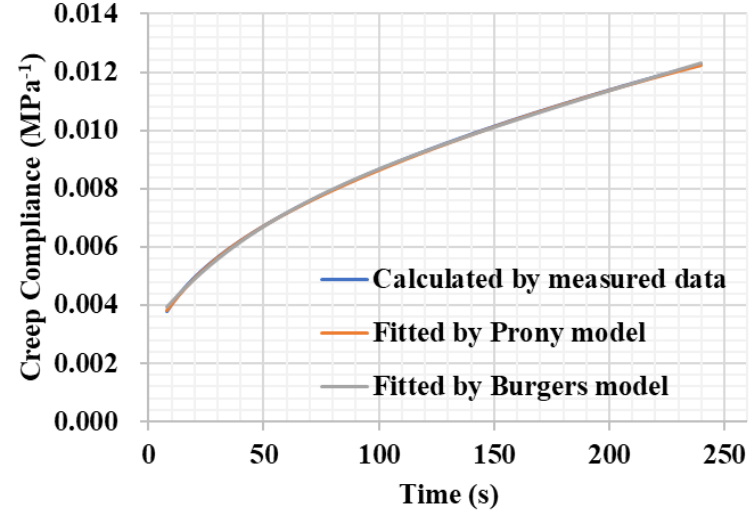
Figure 6. Creep compliance curves determined using different methods in a BBR test. In the Burgers model, E 1 and E 2 are the instantaneous elastic modulus of the Maxwell model and the delayed elastic modulus of the Kelvin model, respectively, while both η 1 and η 2 are viscous coefficients. These viscoelastic parameters can further calculate the indexes of relaxation time λ and the delay time τ , which are determined using Equations (6) and (7). Relaxation time λ shows the ability of asphalt binder to release internal stress, and delay time τ often indicates creep and delayed elastic performance. A shorter relaxation time λ often means a better viscous performance, while a larger τ usually indicates a much more viscous deformation, which means a good anti-cracking ability at a low temperature.